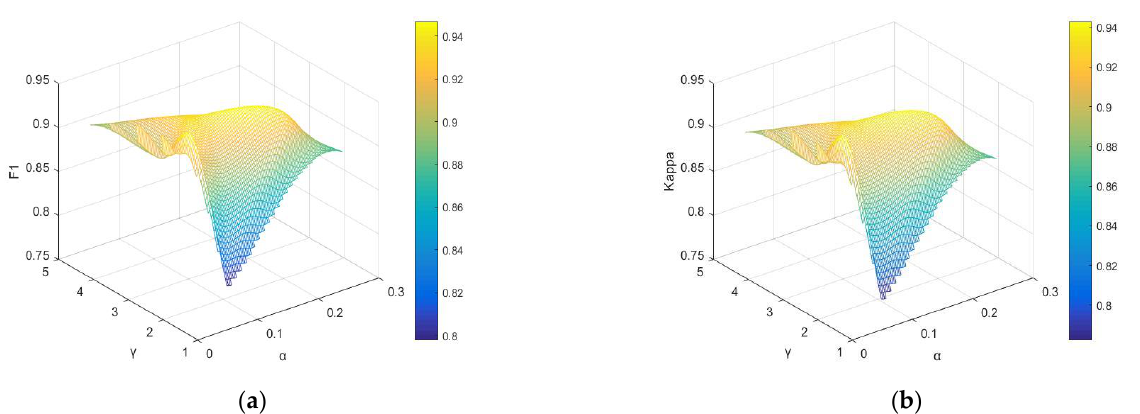
Figure 8. Triangular surface maps of F1 and Kappa on the verification sets: ( a ) F1-score of verification set 4; and ( b ) Kappa coefficient of verification set 4.